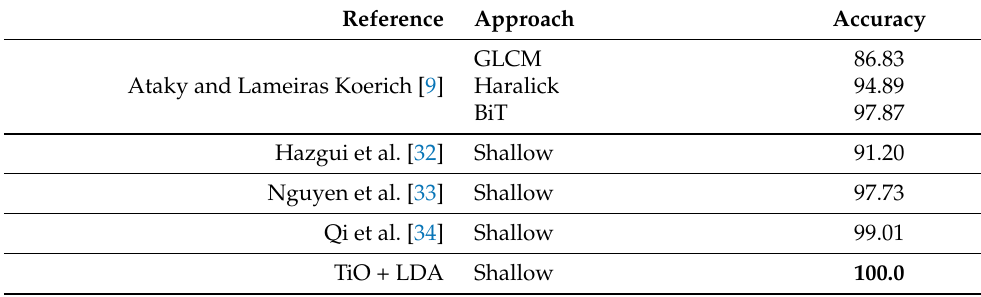
Table 5. Accuracy (%) of the proposed method and related works on the KTH-TIPS dataset. The best result is shown in boldface.